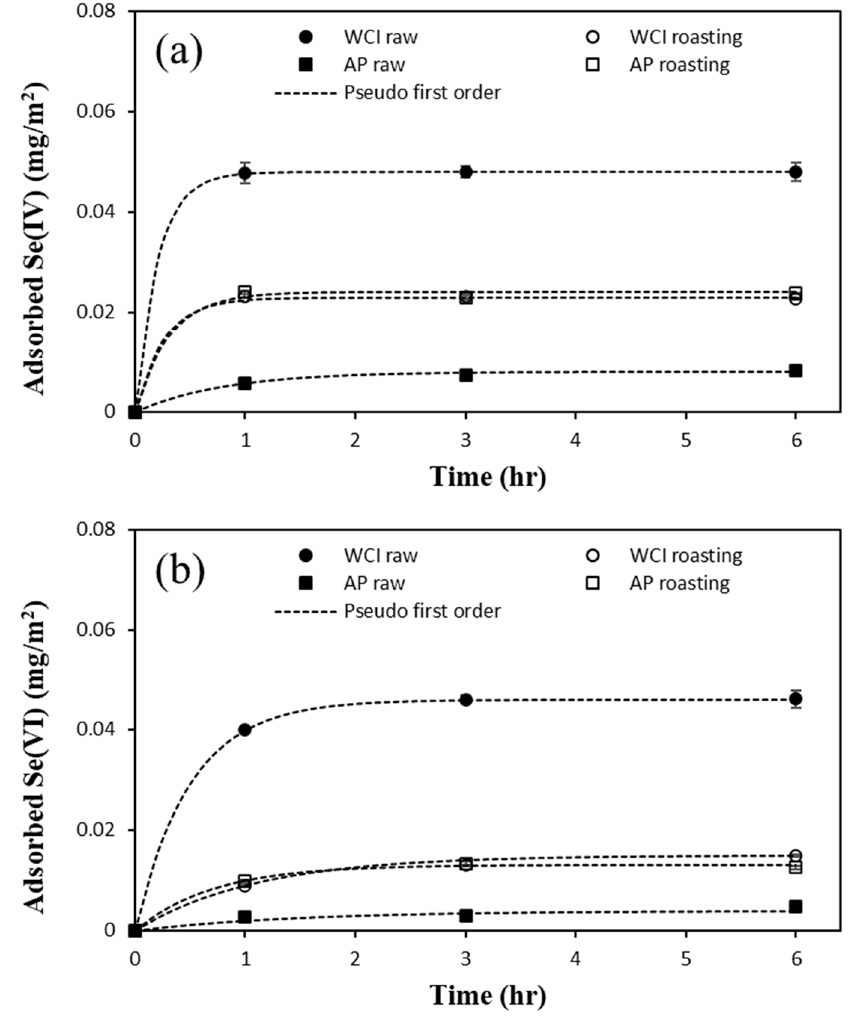
Figure 3. Adsorption capacity of ( a ) Se(IV) and ( b ) Se(VI) on WCI and α -Alumina (AP) before and after roasting at 1250 °C. Table 3. Model parameters for the pseudo-first-order kinetic model based on fits to the adsorption kinetic curves.